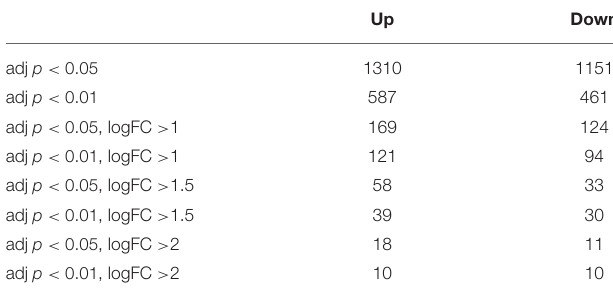
TABLE 1 | Number of significantly up-or down-regulated genes using different adjusted p -values and log fold changes (logFC).